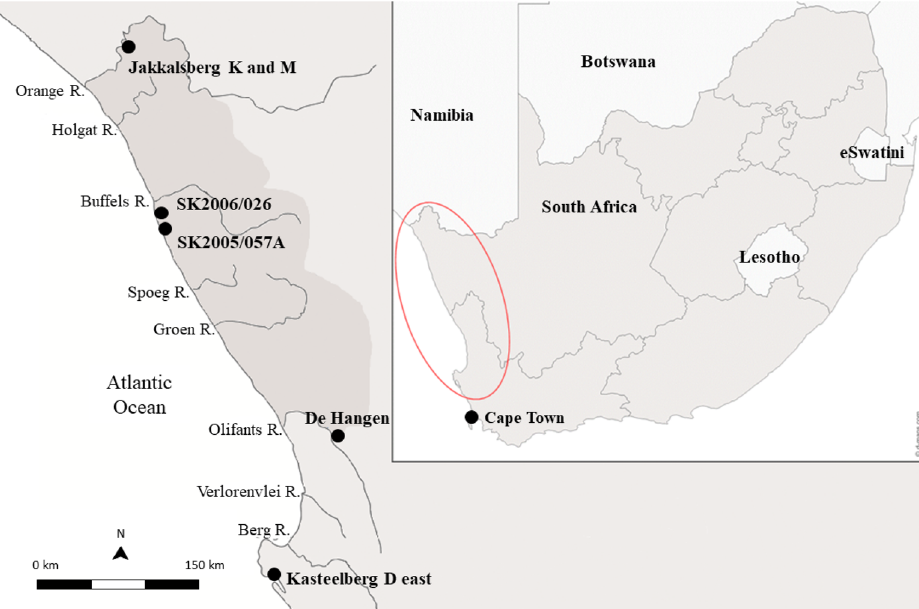
Figure 1. Map of Southern Africa (inset) with Namaqualand enclosed in the darker grey area with approximate location of the archaeological sites mentioned in this study noted. Inset map adapted from https://d- maps. com/ carte. php? num_ car= 4412& lang= en using Adobe Illustrator v. 27.1 (https:// www. adobe. com/). Enlarged map adapted using Google Maps (https:// www. google. com/ maps) in Adobe Illustrator v.27.1 (https:// www. adobe. com/).